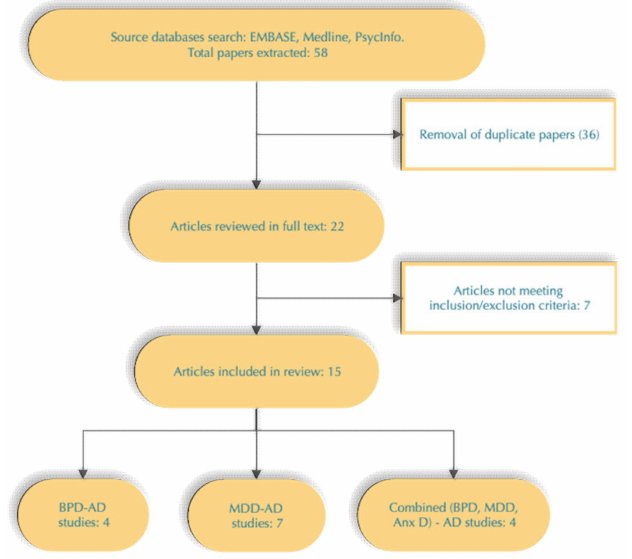
Figure 1. Study selection